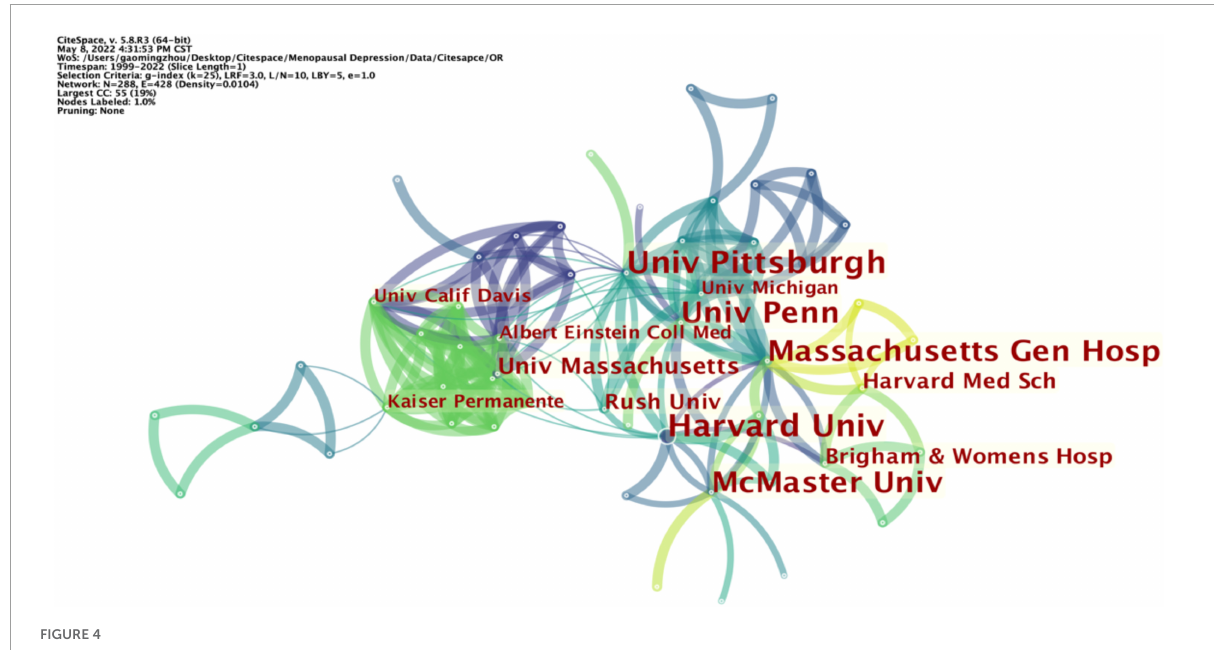
FIGURE4 Distribution of publications from different